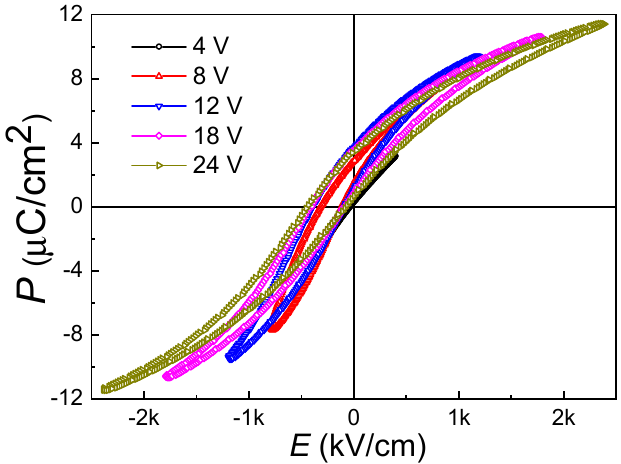
Figure 4. Room-temperature P - E hysteresis loops of the (110)-oriented epitaxial BZT-BCT thin films.